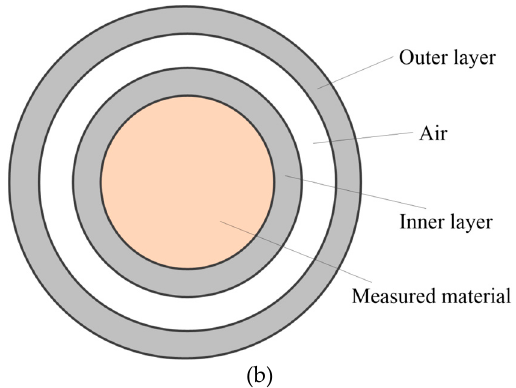
Figure 2. Measurement system diagram: ( a ) the whole system, ( b ) top view of the glass tube.